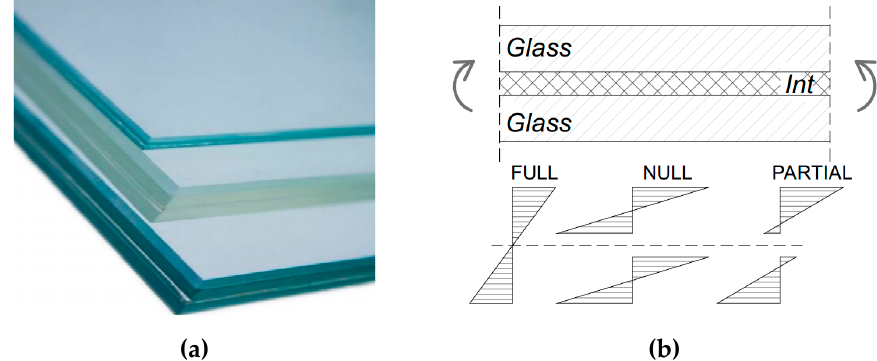
Figure 1. Laminated glass element: ( a ) cross-section examples and ( b ) corresponding stress distributions, depending on the shear coupling efficiency of the interlayers.